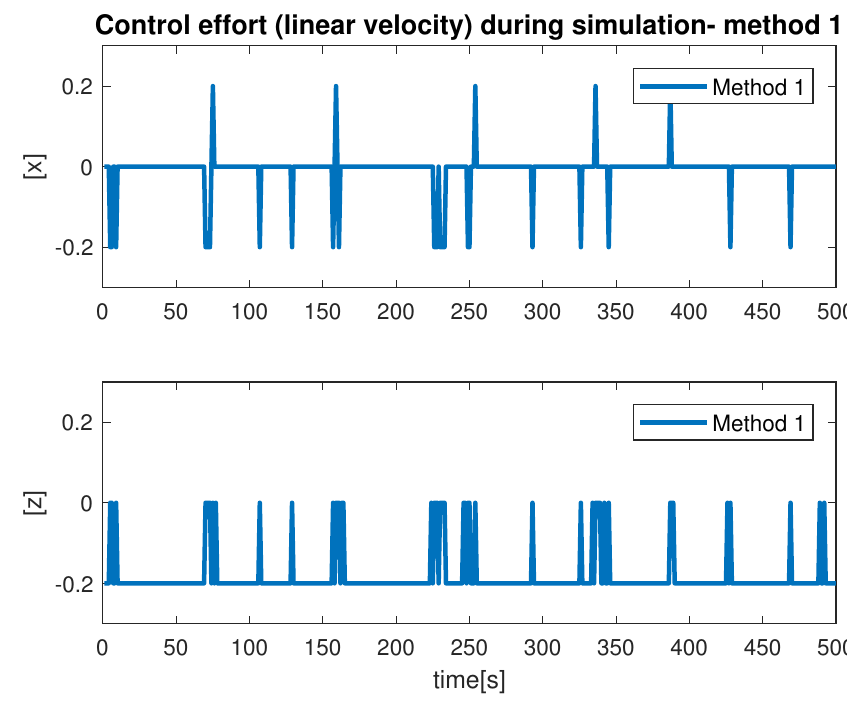
Figure 14. Velocity profile by Method 1.